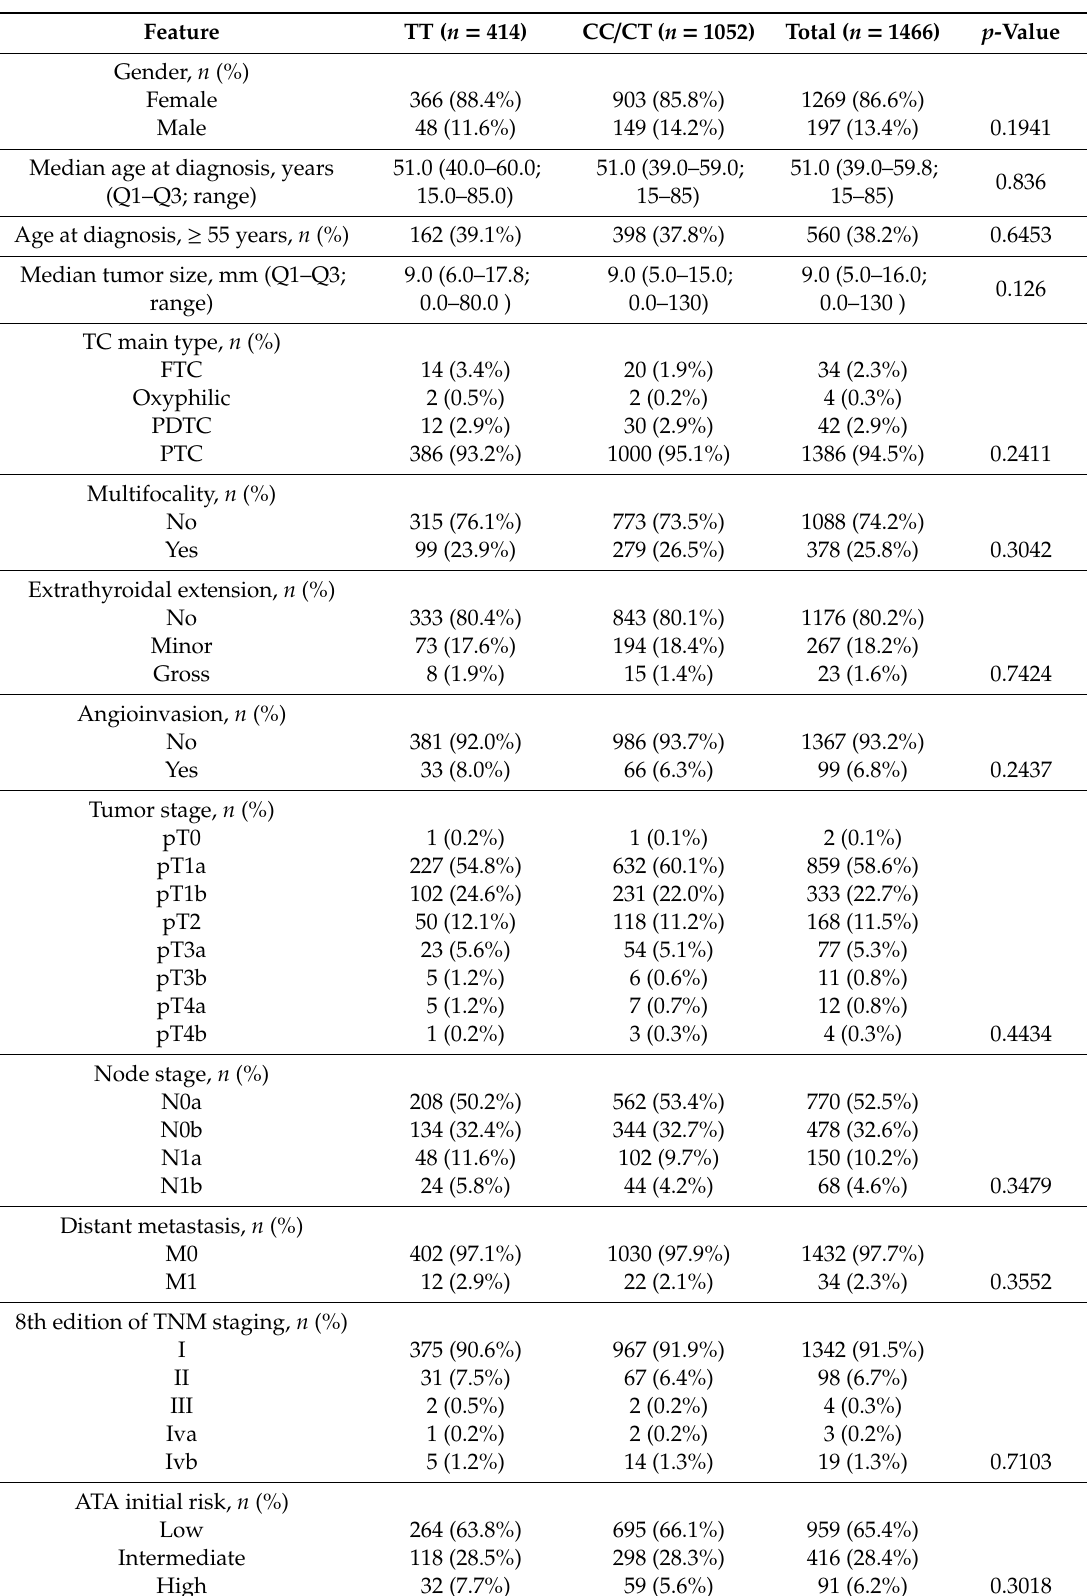
Table 4. Relationships between rs966423 variants and histopathological and clinical